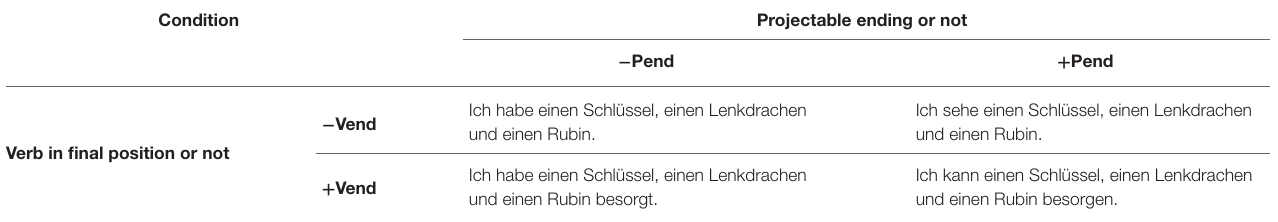
TABLE 1 | Example sentences of the four conditions used in the experiment. Condition Projectable ending or not −